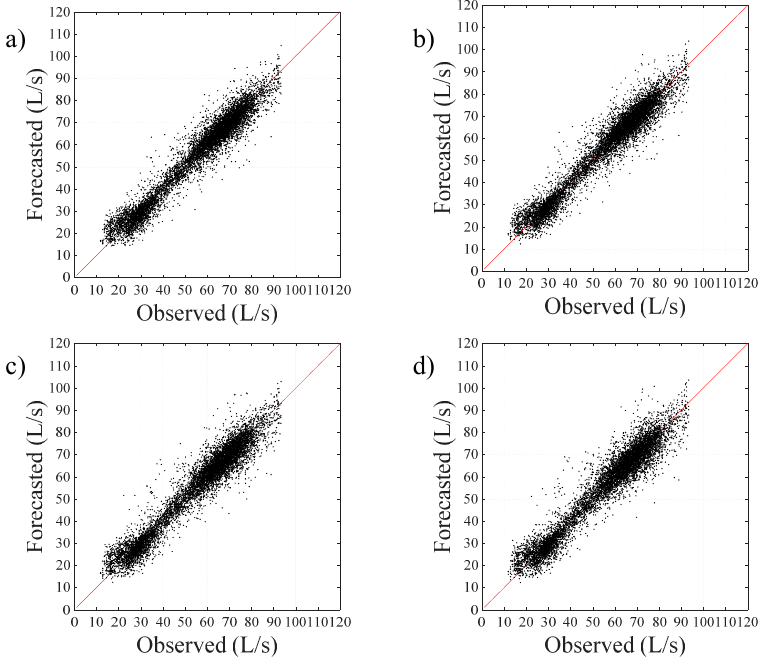
Figure 6. Scatter plot of the ( a ) 1-h-ahead; ( b ) 6-h-ahead; ( c ) 12-h-ahead; and ( d ) 24-h-ahead forecasts provided by the αβ _WDF model for the year 1998.